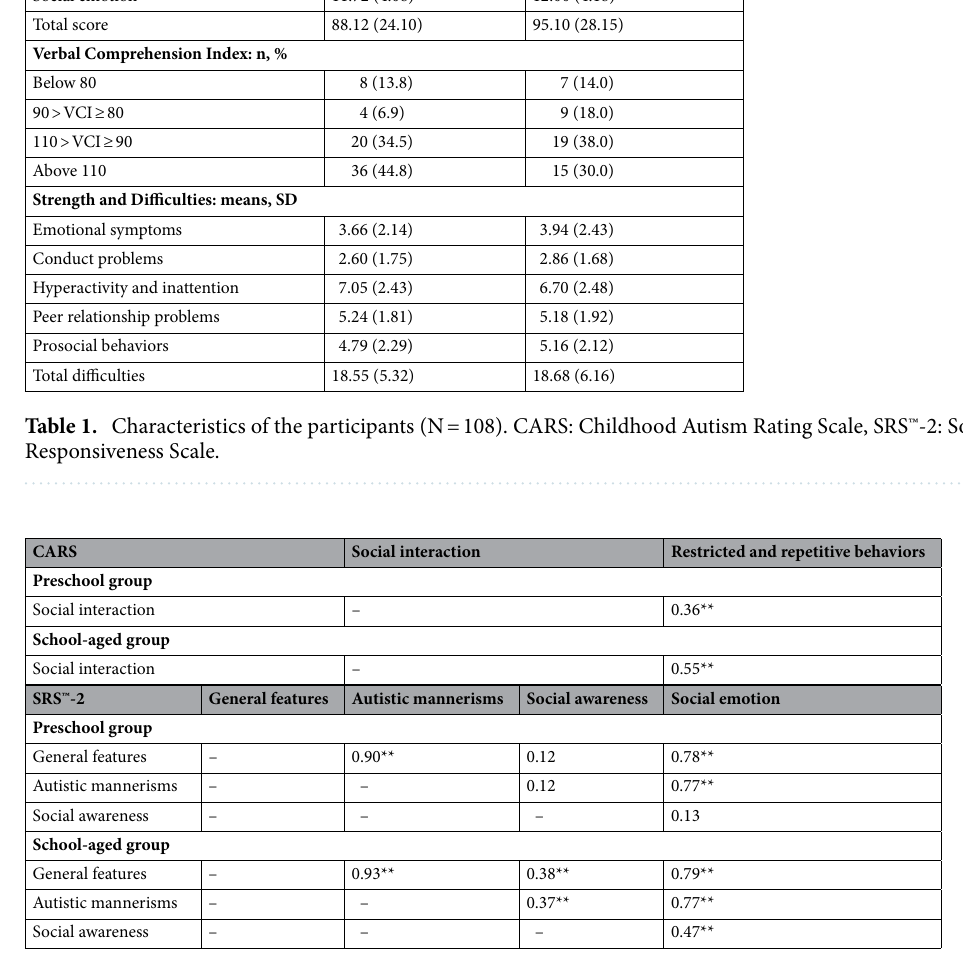
Table 2. The correlations of the five subscales of the SDQ with the subscales of both the CARS and the SRS™- 2. (N = 108). * p < . 05; ** p < . 01, CARS: Childhood Autism Rating Scale, SRS™-2: Social Responsiveness Scale.